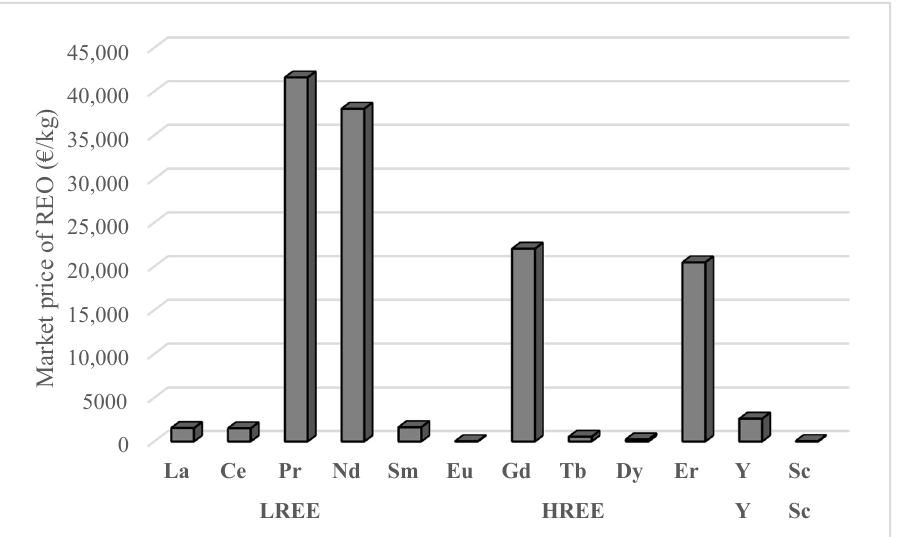
Figure 2. The actual market prices of rare earths: light rare earth elements (LREE) (La-Sm) + heavy rare earth elements (HREE) (Eu-Er) + Y + Sc. The prices (€) correspond to 1 kg of REO of high purity (> 99.5%), updated in February 2020 [49].